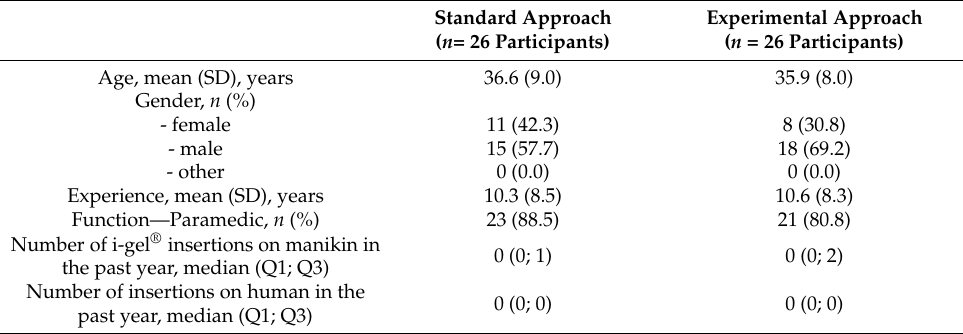
Table 1. Participants’